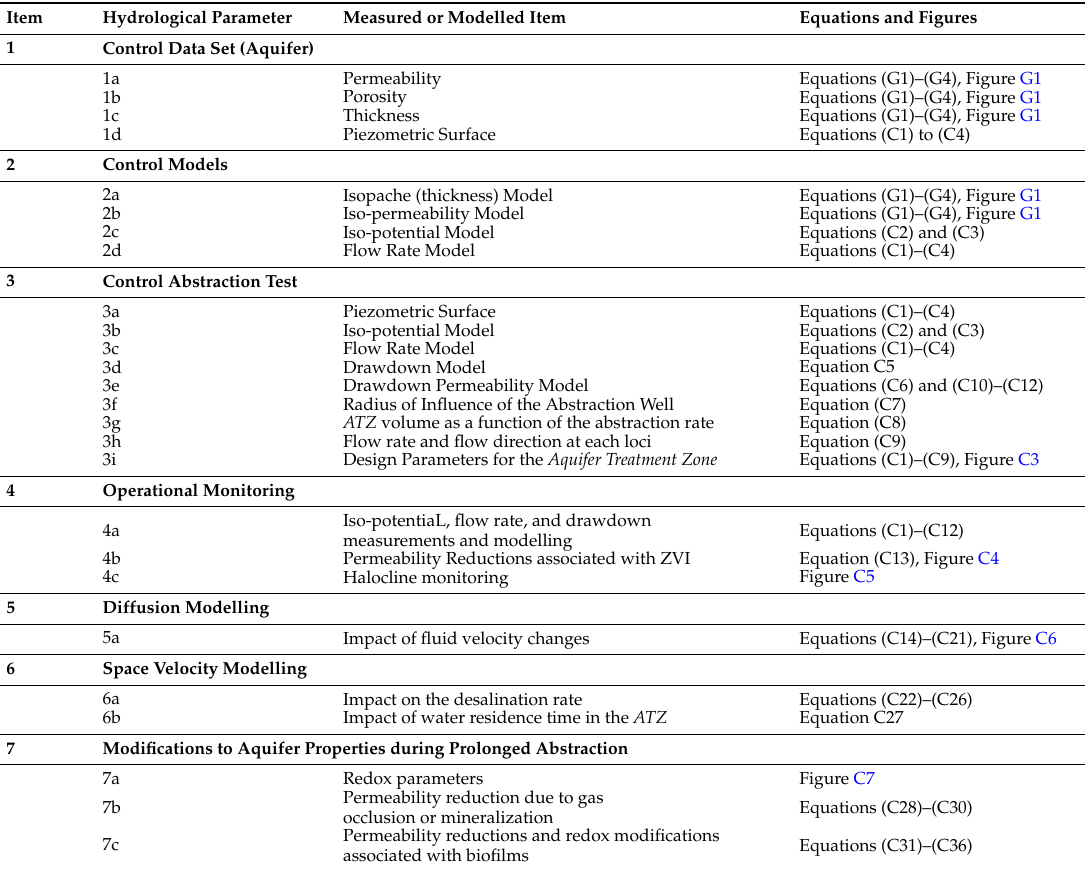
Table 2. Hydrological measurements and modeling required in order to: (i) convert an aquifer into a proposed Aquifer Treatment Zone (ATZ) ; and (ii) monitor the performance of an installed Aquifer Treatment Zone . Further details are provided in Appendixs C and